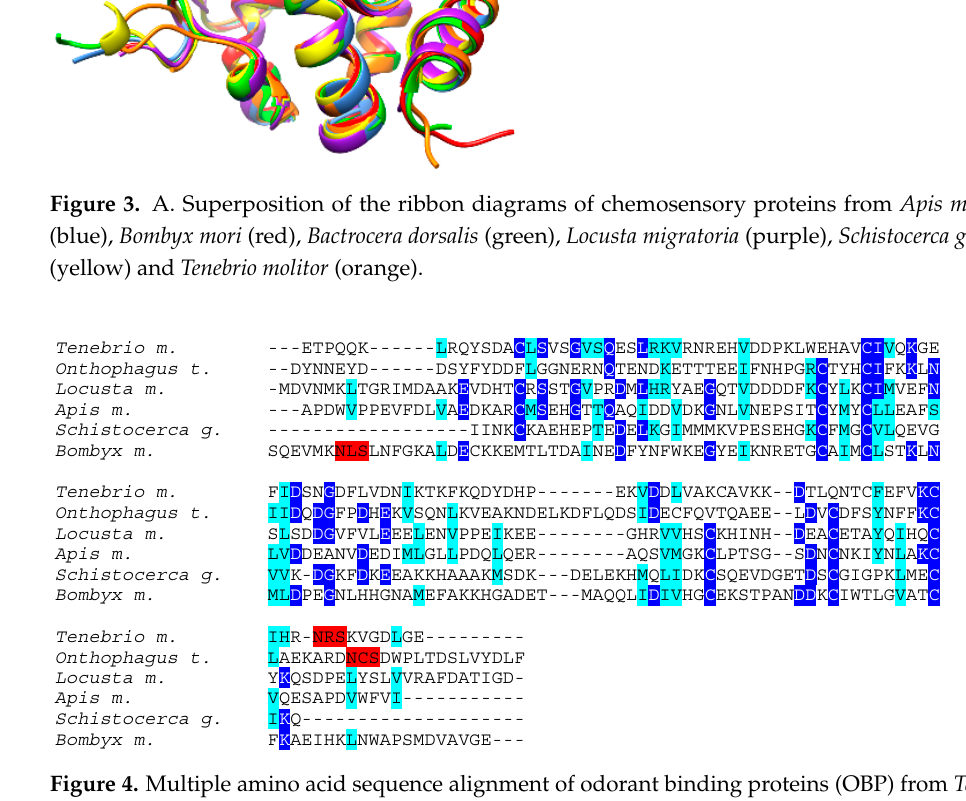
Figure 4. Multiple amino acid sequence alignment of odorant binding proteins (OBP) from Tenebrio molitor ( Tenebrio m .), Onthophagus taurus ( Onthophagus t .), Locusta migratoria ( Locusta m .), Apis mellifera ( Apis m .), Schistocerca gregaria ( Schistocerca g .) and Bombyx mori ( Bombyx m .). Identical amino acids are displayed in white letters highlighted in blue, homologous amino acids are displayed in black letters highlighted in cyan, and putative N -glycosylation sites are highlighted in red.